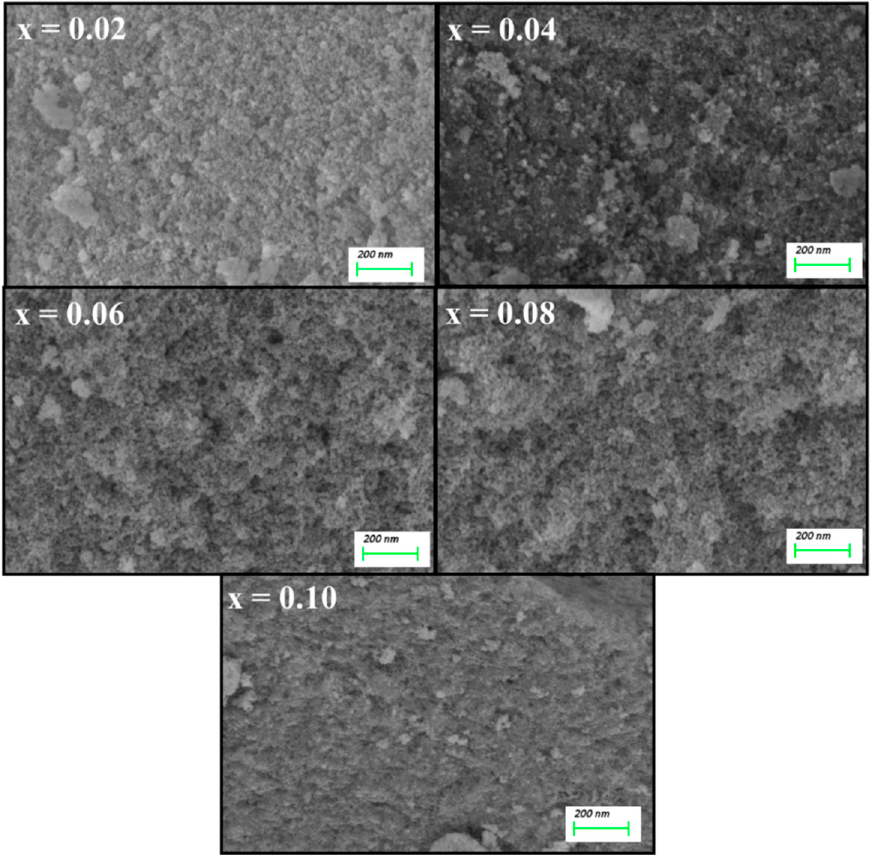
Figure 2. FE-SEM images of Mn 0.5 Zn 0.5 Er x Y x Fe 2-2x O 4 NPs (x = 0.02, 0.04, 0.06, 0.08, 0.10).